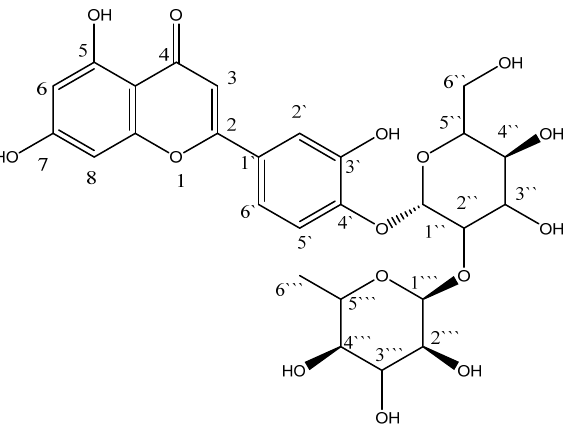
Figure 1. Structure of luteolin 4 ′‐ neohesperidoside (L4N).